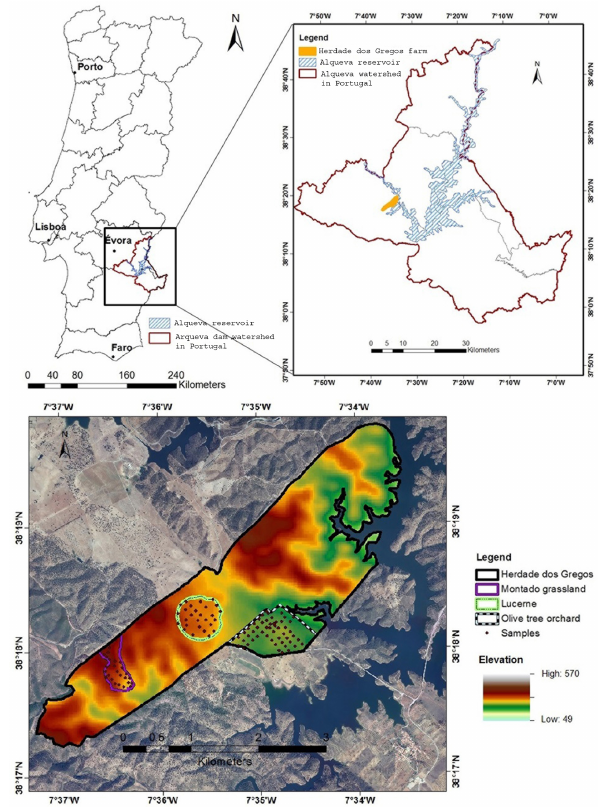
Figure 1. Location of the study area at the Alqueva dam watershed in